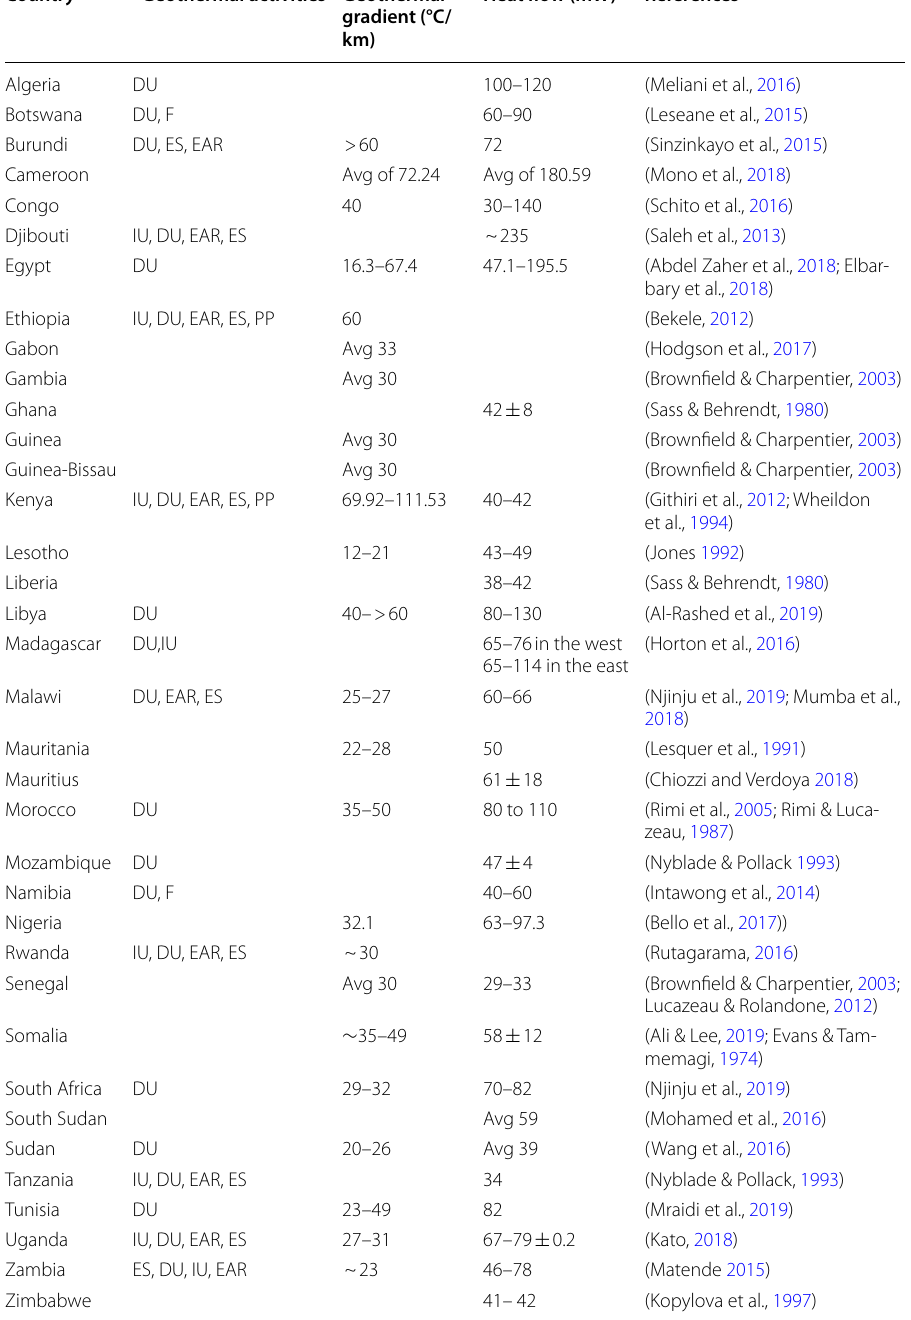
Table 2 Geothermal activities, temperature gradients, and heat flows of some African countries based on various previous